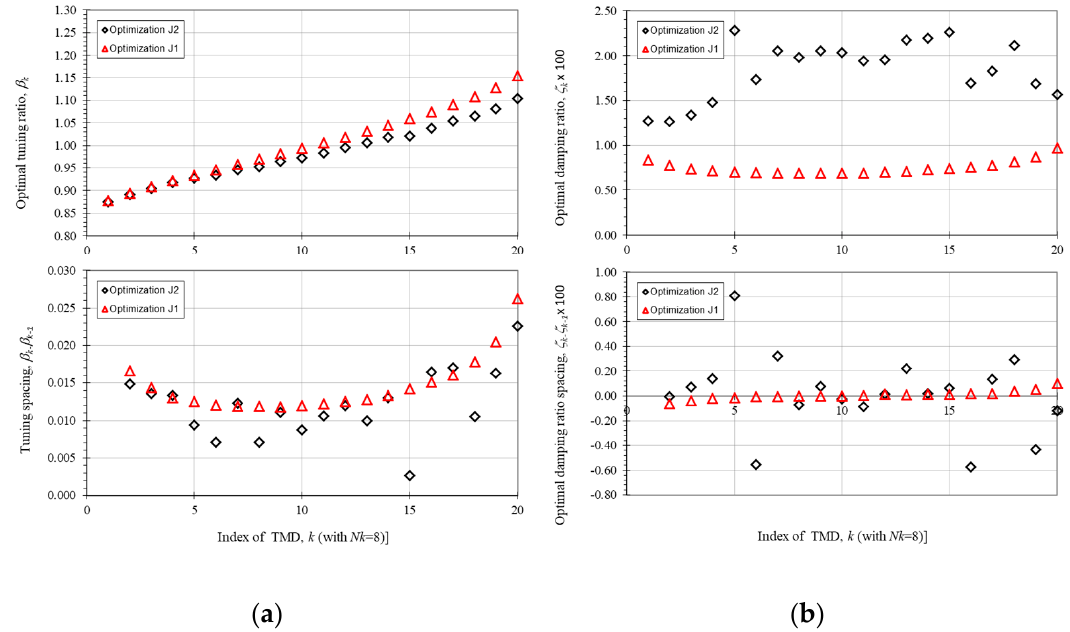
Figure 16. ( a ) Optimal tuning ratios β k and optimal tuning spacings β k − β k − 1 ; ( b ) optimal damping ratios ζ kt and damping ratios’ spacings ζ k − ζ k − 1 of the individual TMD for N k = 20, µ = 0.02, and ζ 1 =